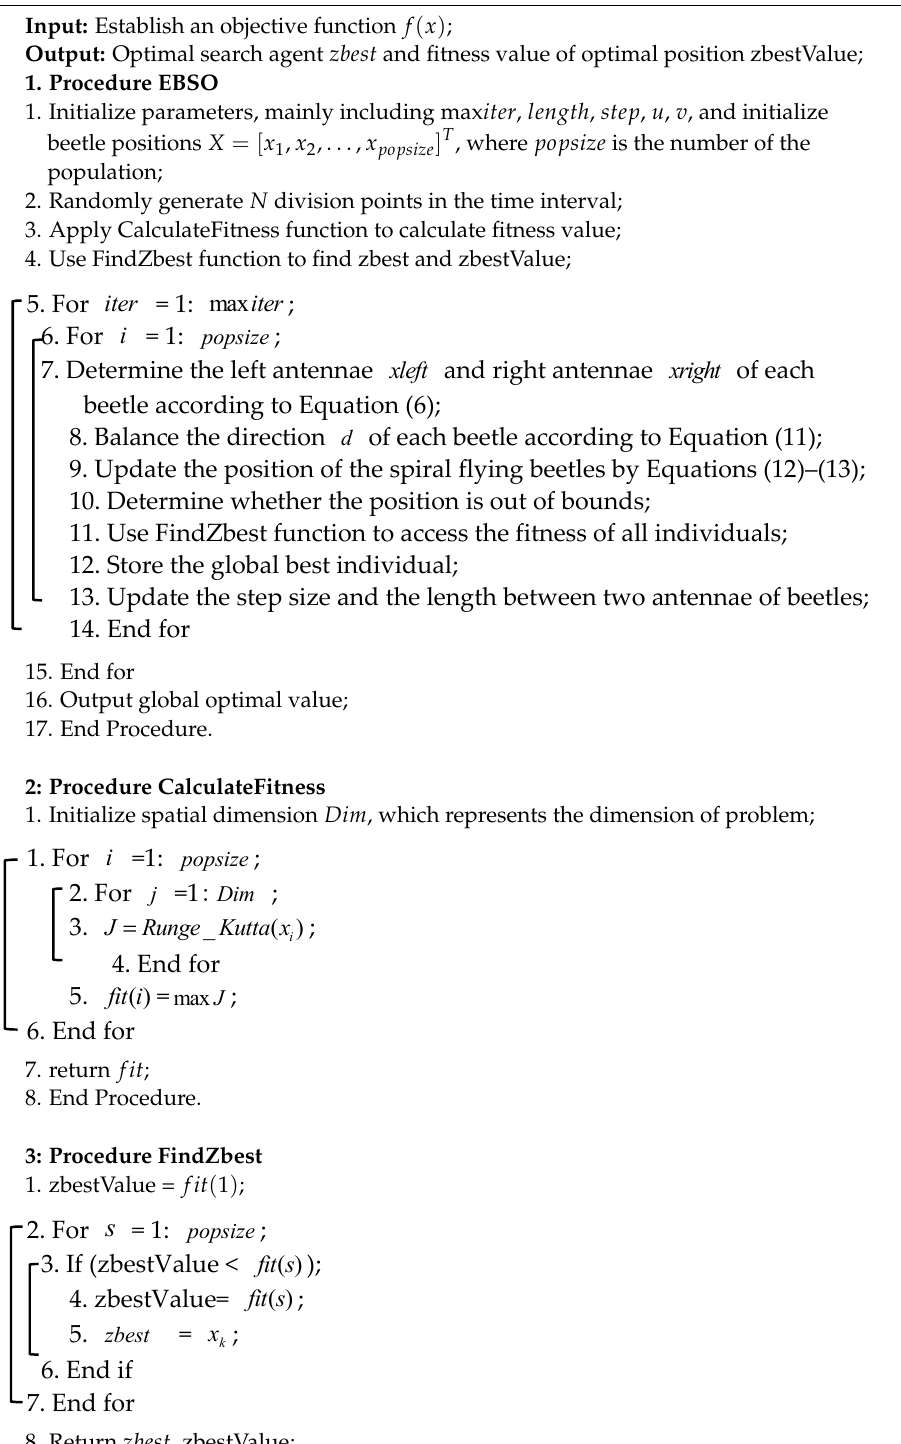
Algorithm 2: Enhanced Beetle Antennae Optimization Algorithm (EBSO)